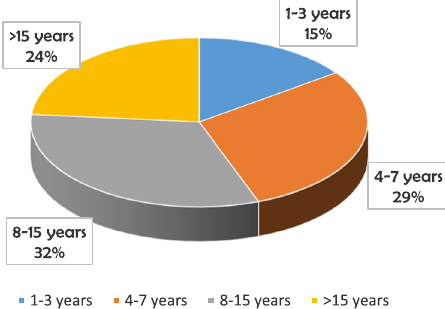
Fig. 2 Service years in the current organization. Percentage of respondents ’ service years in the current